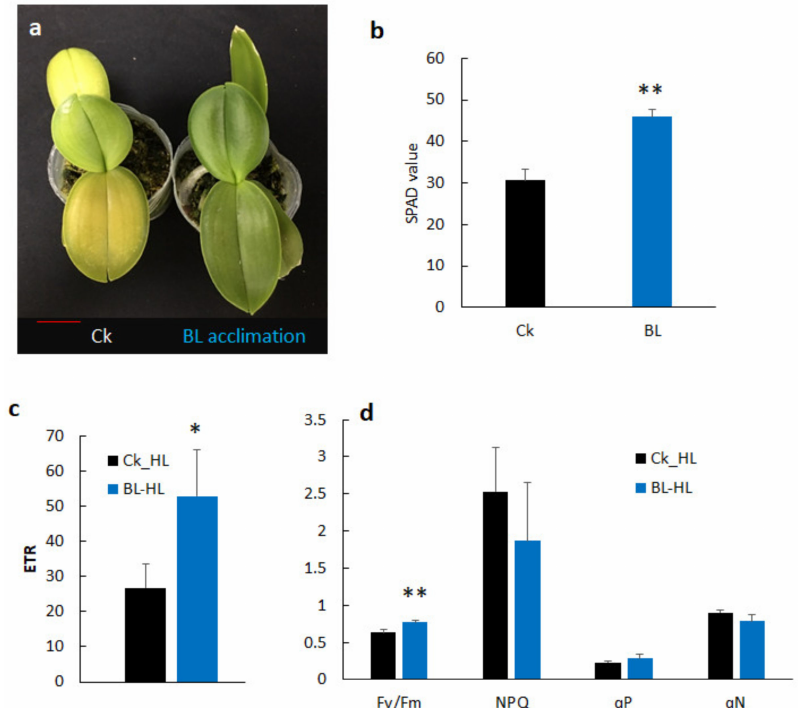
Figure 4. Blue light acclimation improved orchid growth and chlorophyll fluorescence. Orchid seedlings without (Ck) or with blue light acclimation for 12 days (BL) were grown under 1000 µ mol m − 2 s − 1 high light conditions for 70 days. ( a ) Comparison of the growth of Ck and BL acclimation. Bar = 2 cm. ( b ) SPAD reading showed BL acclimation increased the chlorophyll content. Comparison of ( c ) ETR and ( d ) other chlorophyll fluorescence parameters between CK and BL acclimation. Abbreviations and statistical analyses are as described in the Figure 3 legend. *, p < 0.05; **, p <